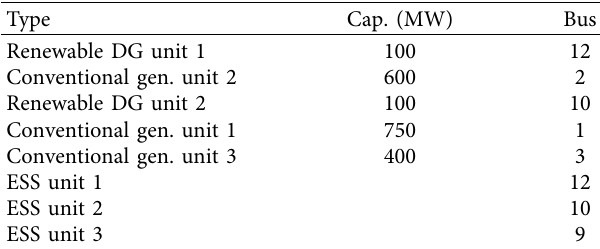
Table 1: Details of IEEE 14-bus standard test scheme.